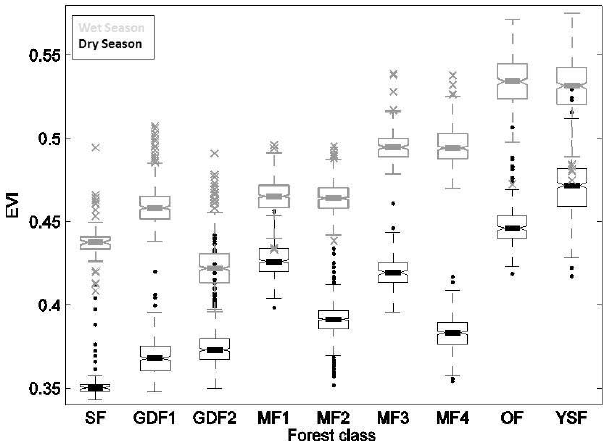
Fig. 2. Distributions of EVI values for the different forest classes. Box plots summarize EVI values aggregated between 2000 and 2011 for each (wet and dry) season. Two-factor (season + class) analysis of variance of EVI test rejected the null-hypothesis of equality-of-mean EVI values for all the types of forests and seasons ( p < 0 . 0001). See also Table 1. Abbreviations: GDF (1–2): mon- odominant Gilbertiodendron dewevrei forests; MF (1–4): mixed forest; OF: open forest; YSF: young secondary forest; SF: swamp